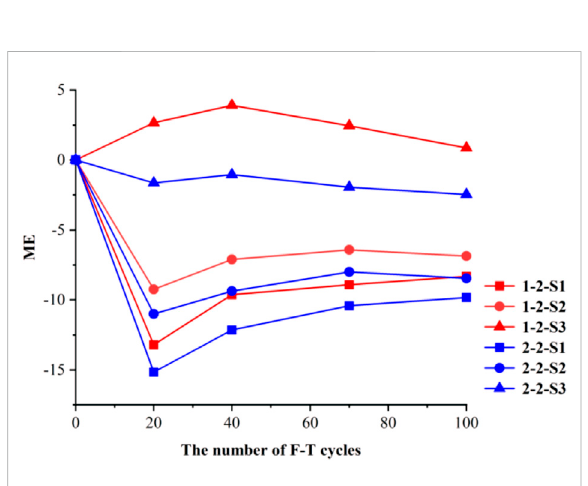
FIGURE 9 ME values for different regions of granite under different numbers of F – T